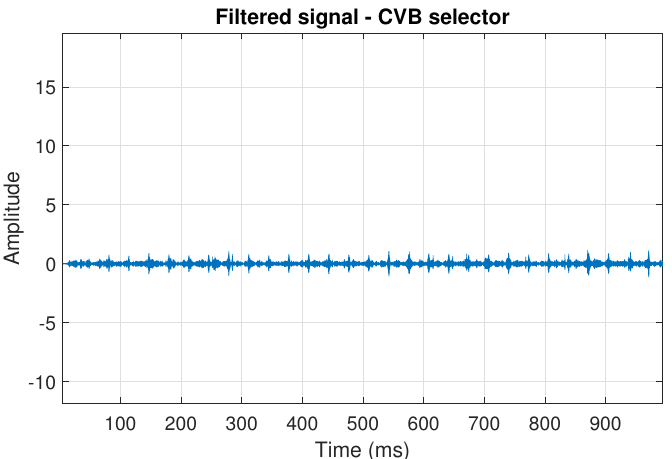
Figure 16. Filtered signal s 2 by CVB selector.